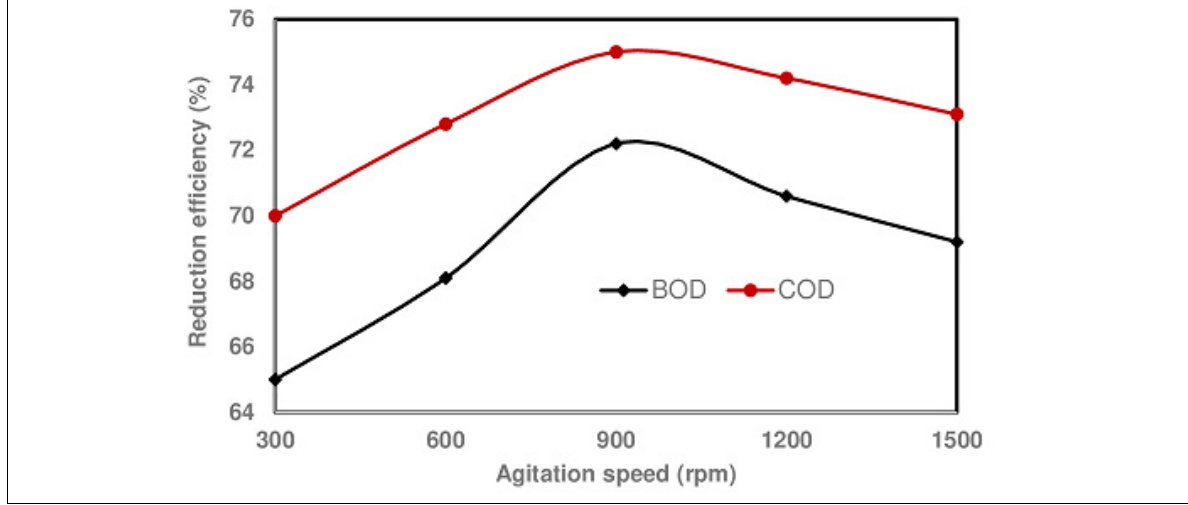
Figure 5: Effect of agitation speed on the reduction efficiency of biological oxygen demand (BOD